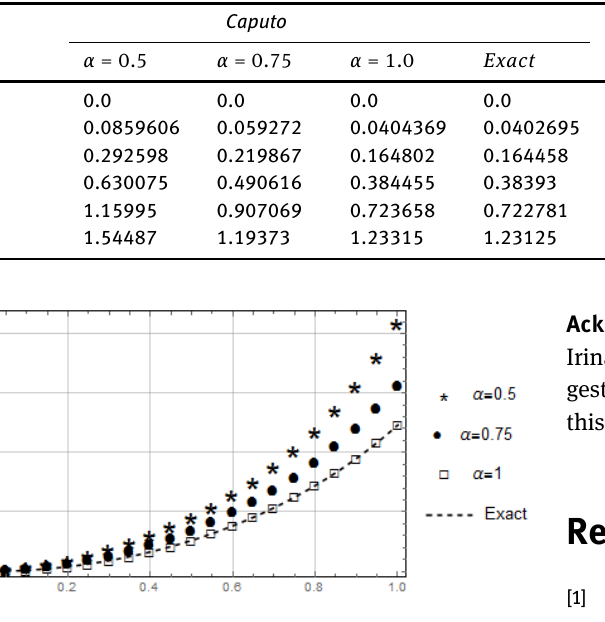
Fig. 4: Comparison betwixt the exact and the approximation so- lution with F -transform of test example 5.2 for value of n = 500 , τ = 0.002 and various values of α and t , with Caputo-Fabrizio